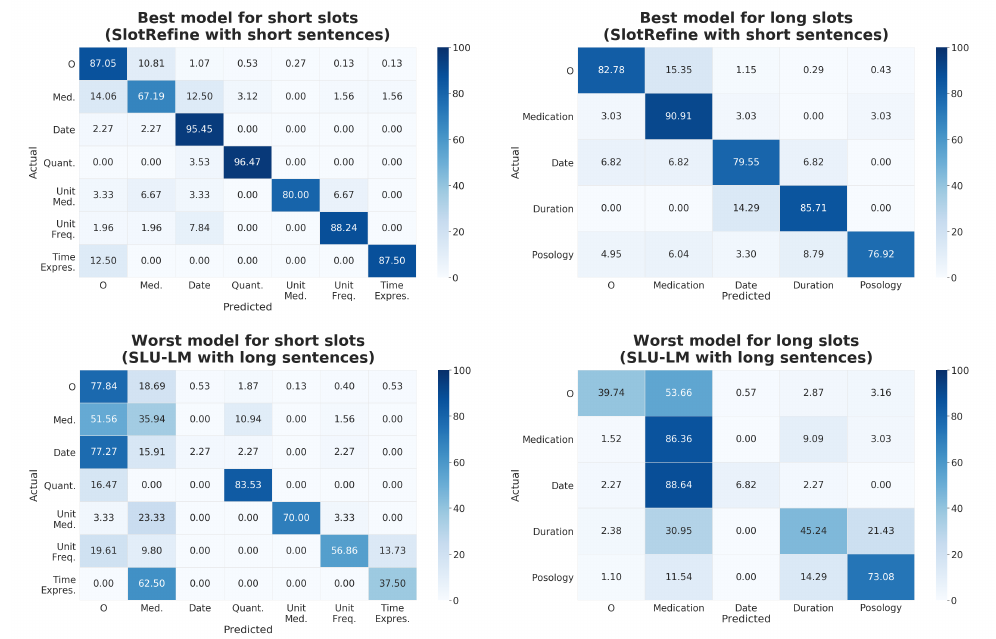
Figure 4. Confusion matrices for the best and the worst models for short and long slots (in